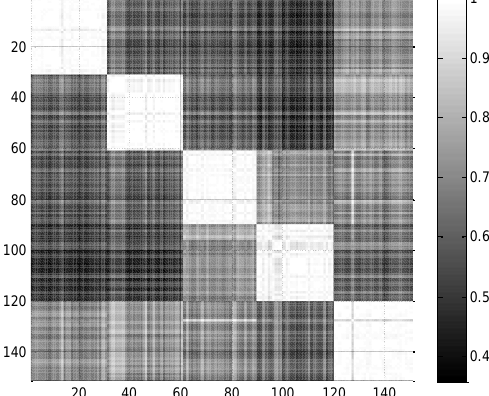
Fig. 7. Representation of matrix T . Columns correspond to the values of the first 5 eigenvectors of sym L of the raw data matrix of Figure 5.